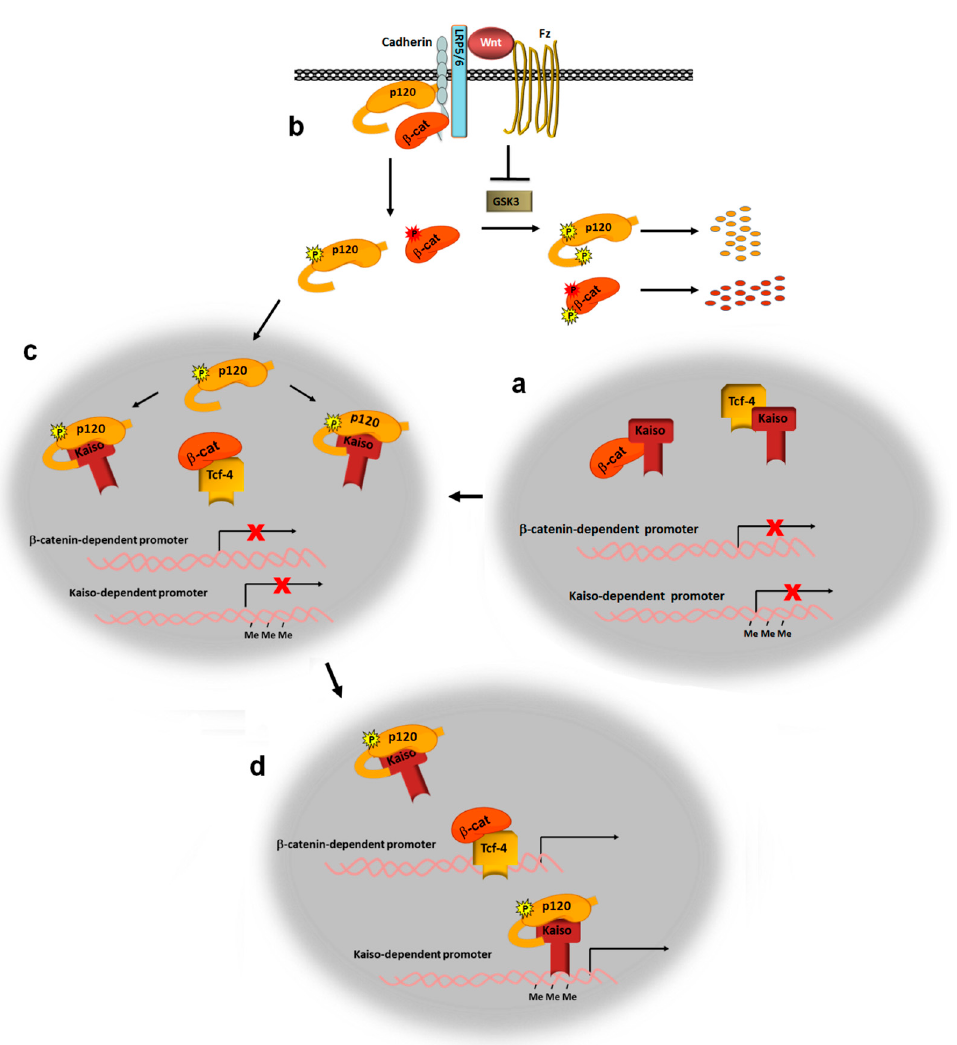
Figure 3. Wnt controls kaiso transcriptional repressor through p120-catenin. In the Wnt “off” state ( a ), kaiso represses β -catenin/TCF4 transcription through its interactions with TCF4, which precludes its binding to DNA, as well as with β -catenin, which inhibits its interaction with TCF4. Upon Wnt stimulation ( b ), p120-catenin and β -catenin that are released from the signalosome through their phosphorylation at Ser268/269 and Tyr142, respectively, are stabilized by the Wnt-induced inhibition of GSK3; this then prevents p120-catenin and β -catenin degradation. In the nucleus ( c ), p120-catenin binds kaiso and disrupts TCF4/kaiso and β -catenin/kaiso interactions, allowing the β -catenin/TCF4 complex to bind its target promoters ( d ). Note that kaiso binding to methylated CpG sequences is not prevented by p120-catenin.